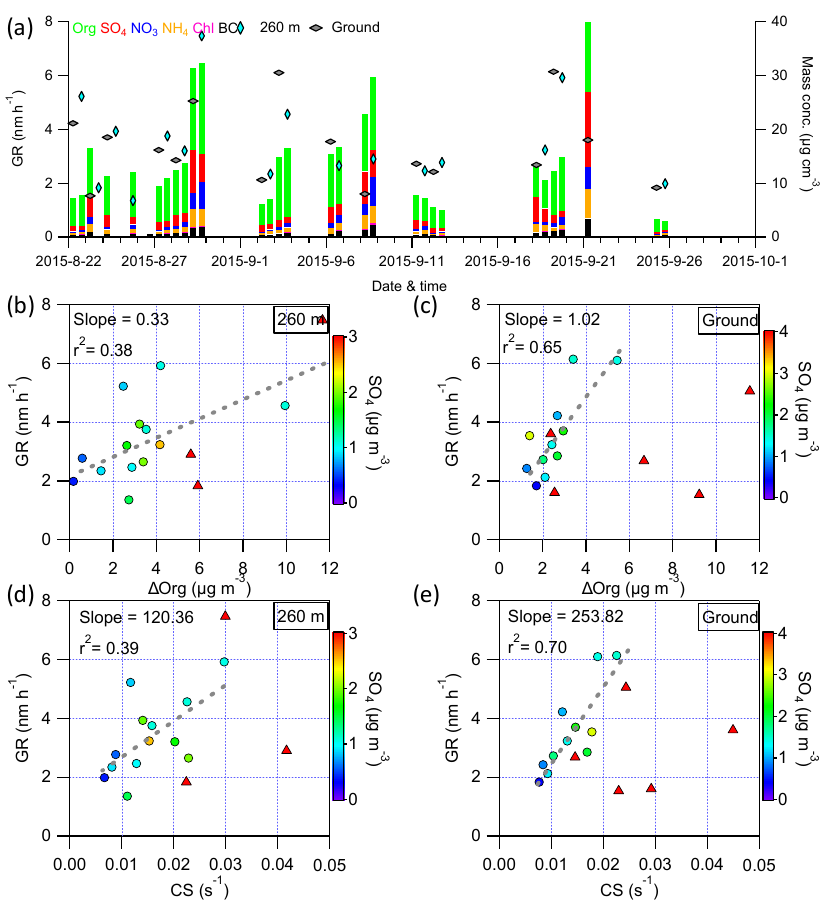
Figure 8. (a) Time series of particle growth rates and corresponding average chemical composition for selected particle growth events. Panels (b) and (c) show the correlation of particle growth rates with the changes in the concentration of organics ( (cid:49) Org) at 260m and ground level, respectively. Panels (d) and (e) show the correlation of particle growth rates with condensation sink at 260m and ground level, respectively. The data points in (b–e) are color coded by the mass concentration of sulfate (SO 4 ) , and those with sulfate concentrations higher than 3µgm − 3 (ground level) and 2.5µgm − 3 (260m) are marked as triangle